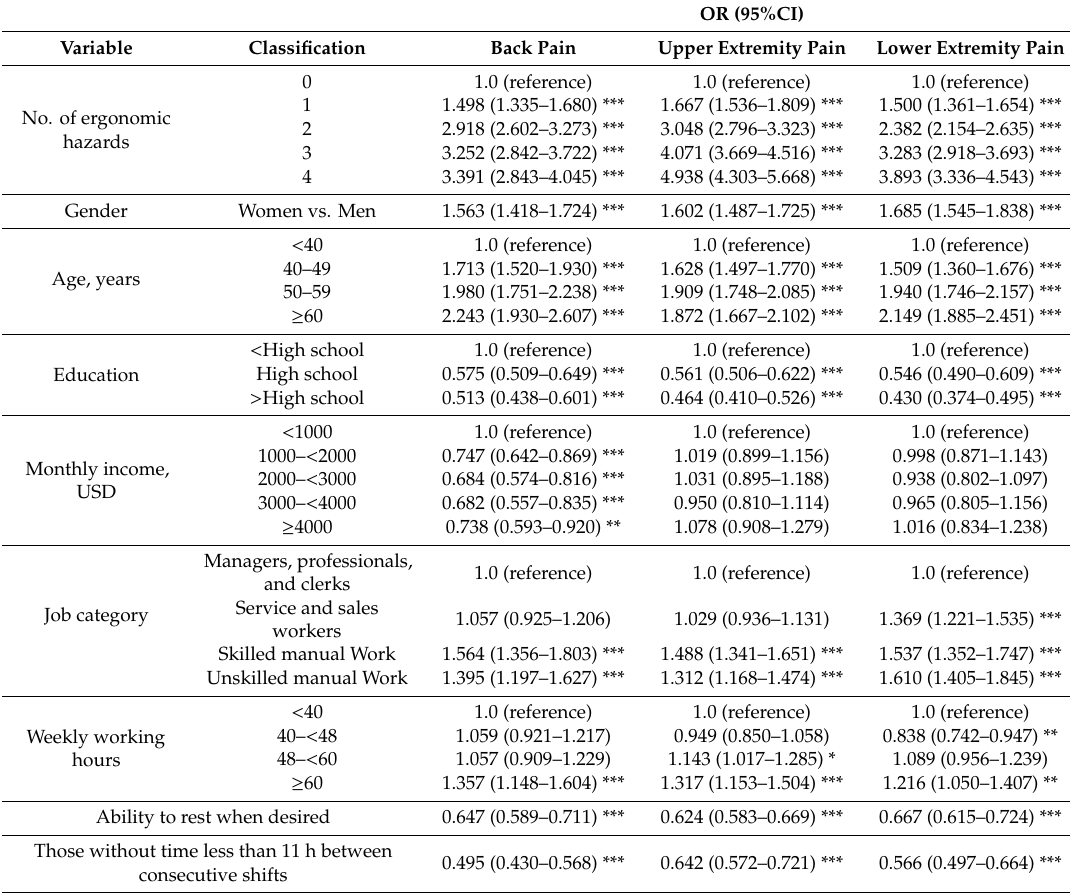
Table 3. Multivariate Logistic analysis of the association of musculoskeletal pain with combined ergonomic hazards, demographic factors, socioeconomic factors, and other factors in